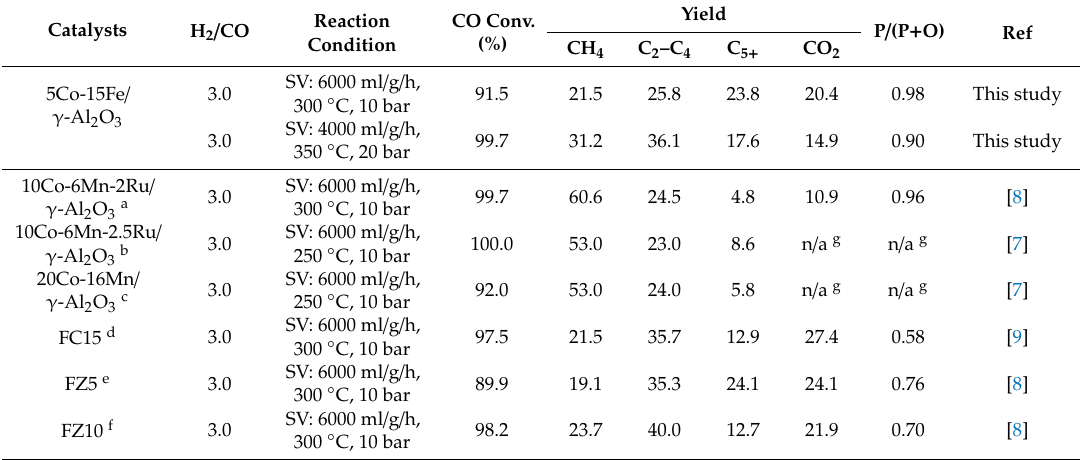
Table 3. Comparison of catalytic performance of FT catalyst (5Co-15Fe / γ -Al 2 O 3 ) with di ff erent catalysts published in other